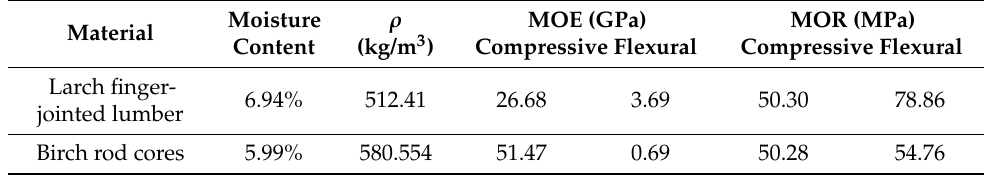
Table 2. Mechanical behavior of raw